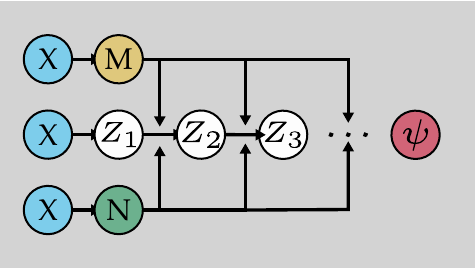
Figure 6. Fully connected deep neural network with skip connections. Spatial information is re- introduced at each layer, to strengthen the spatial gradients in the loss